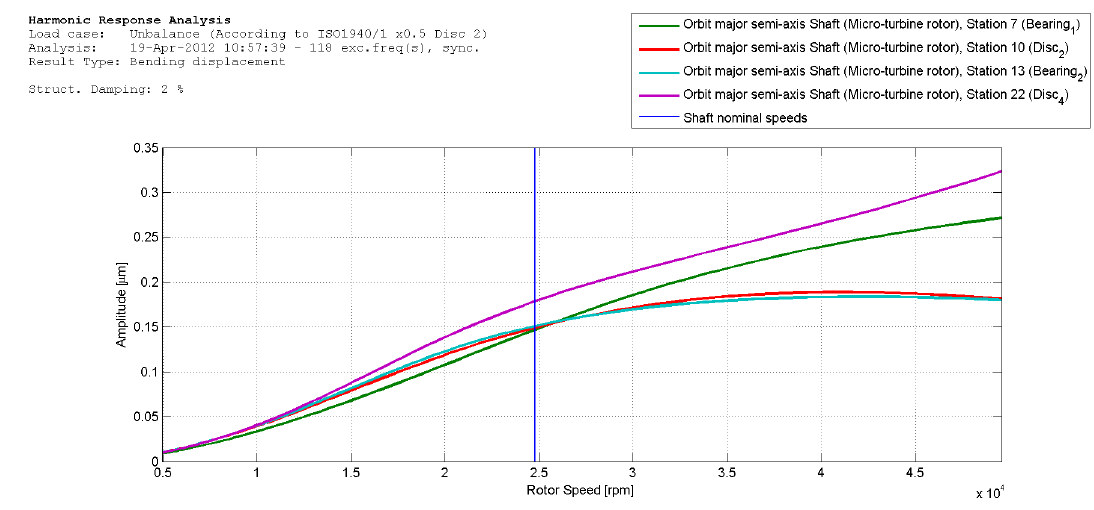
Figure 8: Amplitude of the rotor vibration for the unbalance of the disc No. 2 equal to 0.6 × 10 −6 kg ·